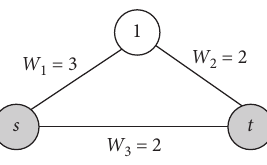
Figure 1: A simple